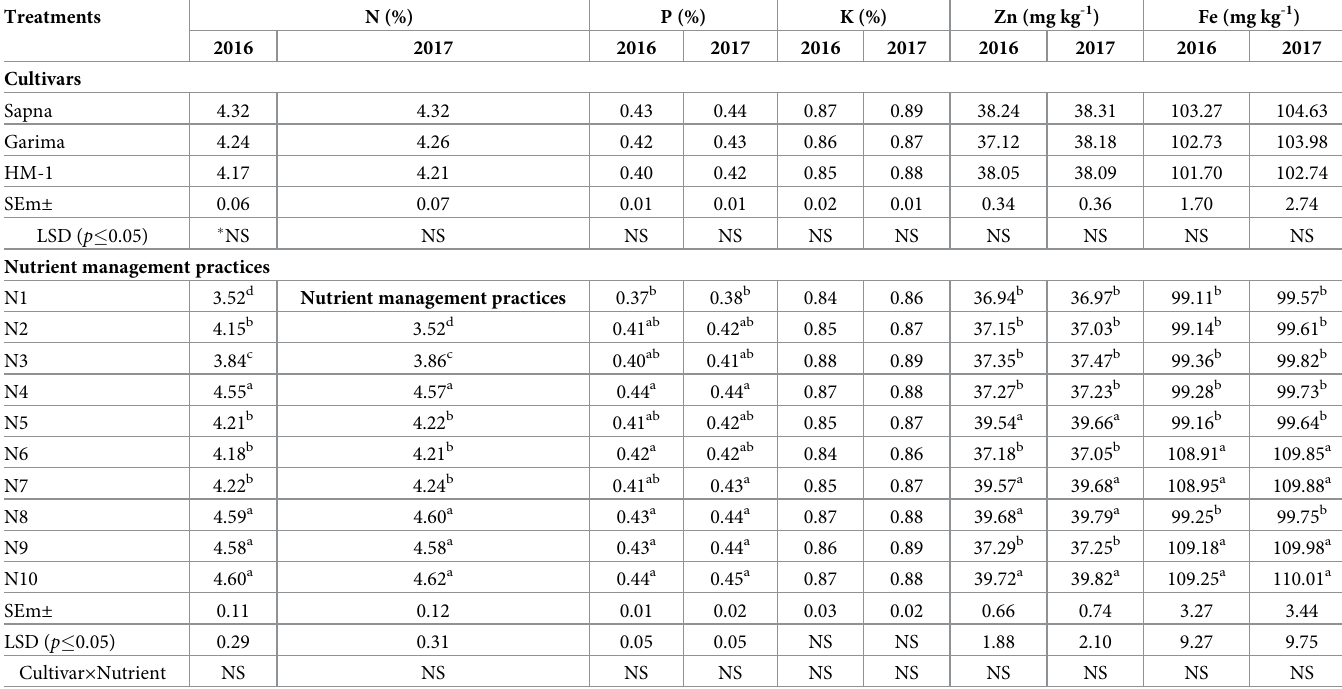
Table 1. Nutrient content in the seed of lentil cultivars under different nutrient management levels.